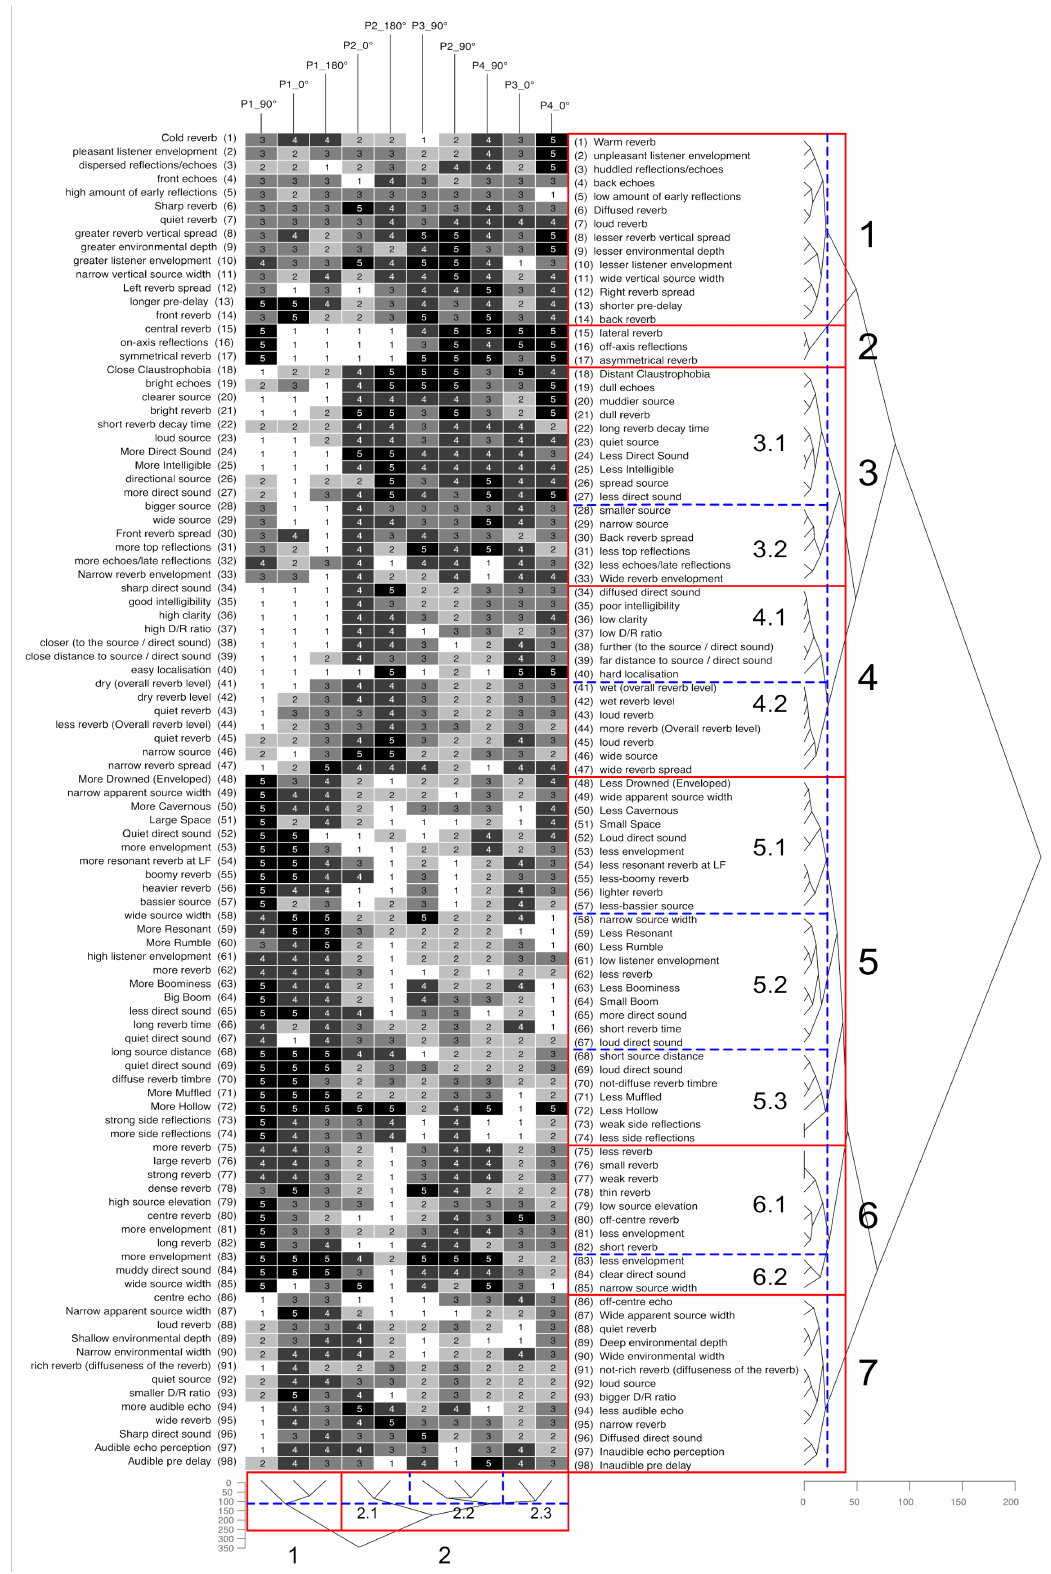
Figure A2. Elicited terms along with the RGT ratings from the laboratory